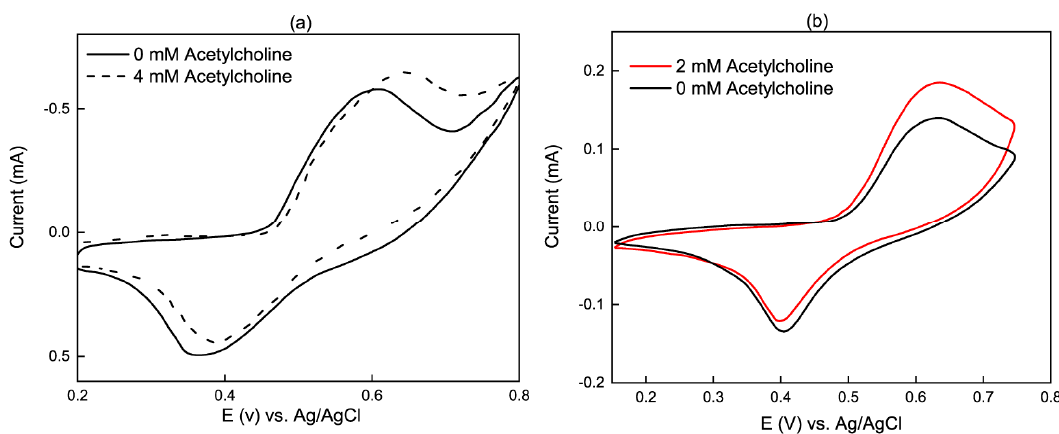
Figure 3. Cyclic voltammetry of acetylcholine sensors at 0.1 V/s. ( a ) Ni–Al LDHs/OMC/GC in 0.1 M NaOH; ( b ) NiAl-LDH/CD/GCE in 0.1 M KOH. Reproduced with permission from [32] and [23] copyright [2012], [2016], Elsevier.